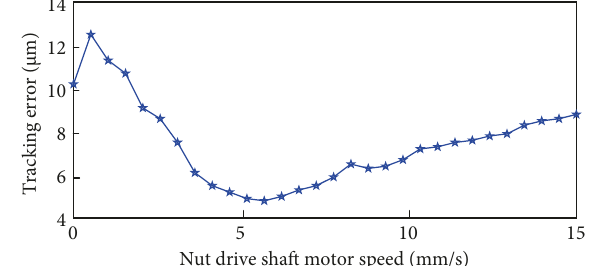
Figure 12: Influence of nut drive shaft speed on tracking error.